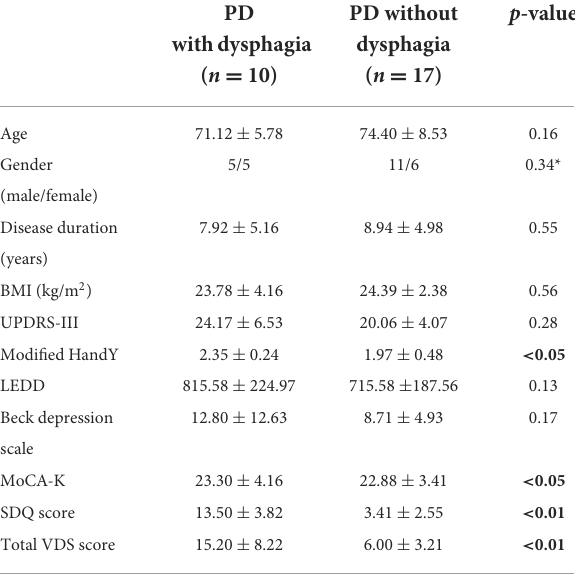
TABLE 1 The demographic parameters of the enrolled PD